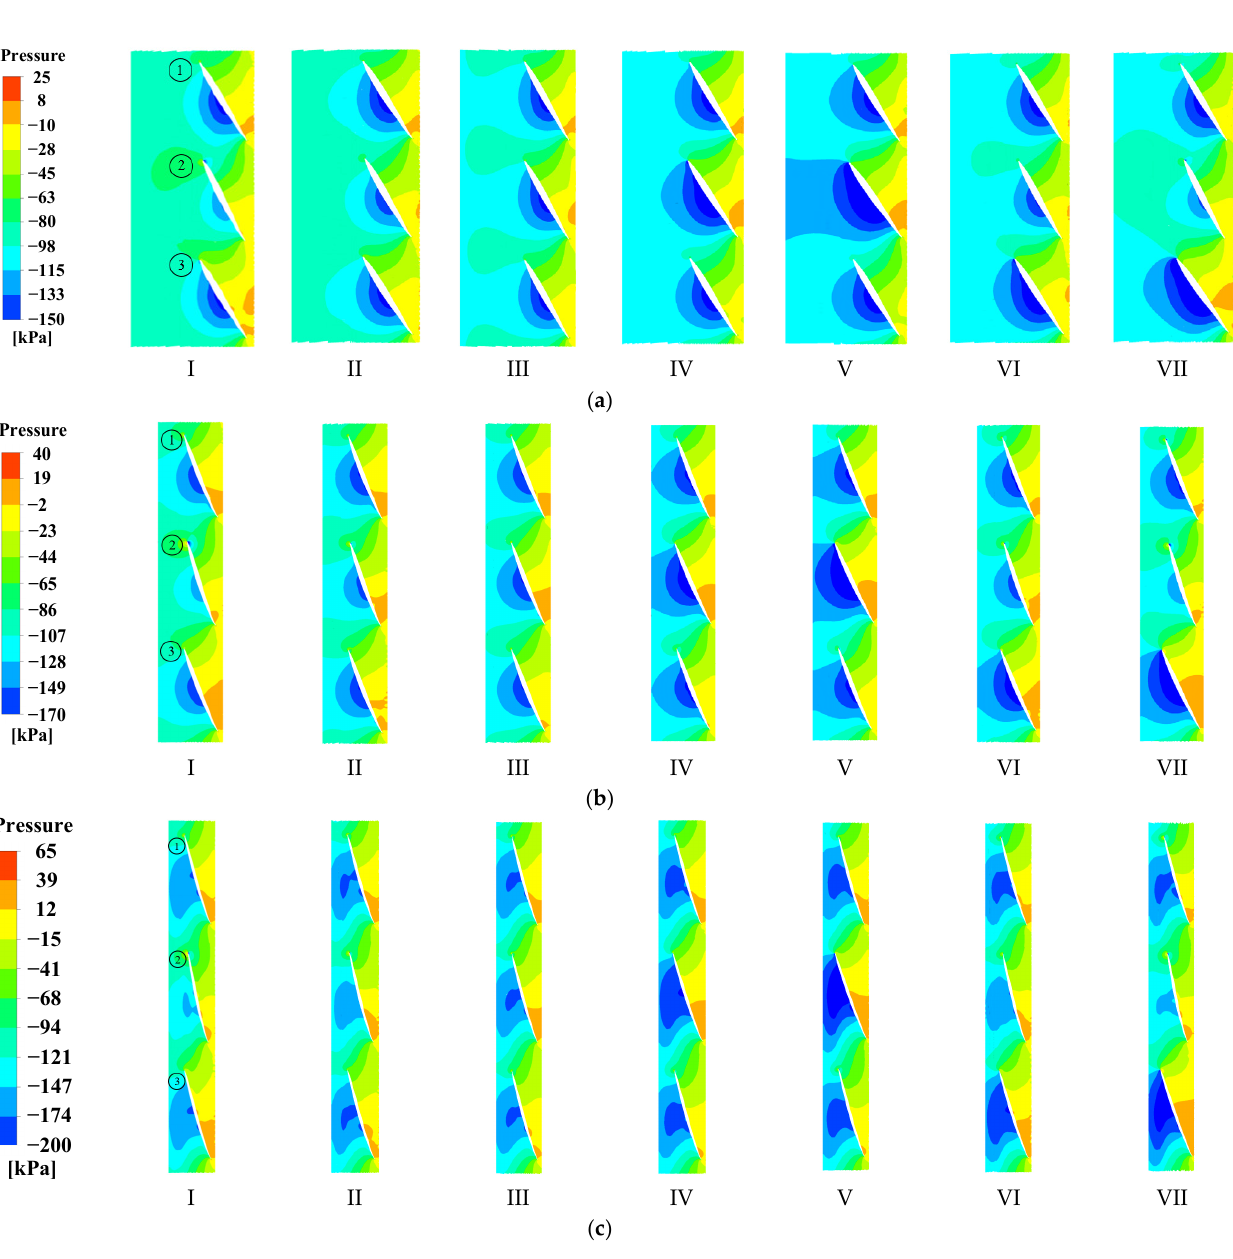
Figure 9. Pressure distribution of each span in the impeller: ( a ) 0.1 span; ( b ) 0.5 span; and ( c ) 0.9